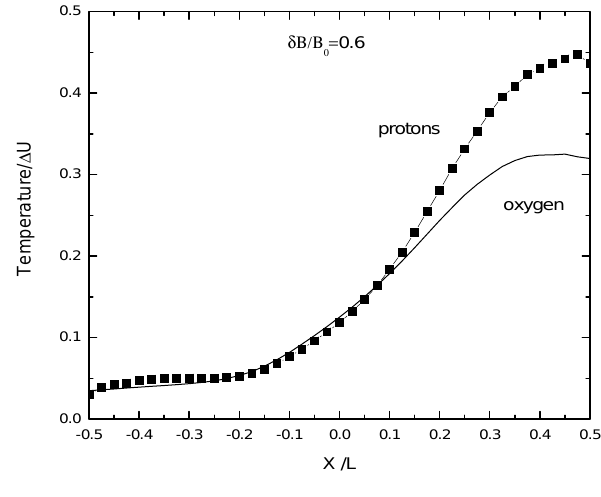
Fig. 3. Density profiles in the simulation box for proton and oxygen ions. Dimensionless units. Fig. 4. Bulk velocity along z in the simulation box for proton and oxygen ions.